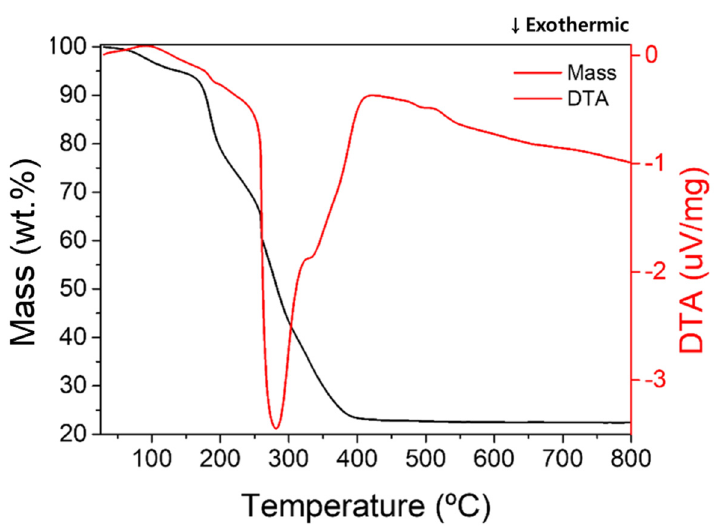
Figure 2. TGA curve of as-spun NZF nanofibers. An initial mass decrease of about 6% occurred in the temperature range of 60 °C to 140 °C, and it was likely due to the volatilization of adsorbed moisture and residual sol- vent. The DTA peaks are 100 °C and 135 °C, respectively, and these reactions are endo- thermic near the boiling points of water and DMF. Endothermic DTA peaks are observed at 100 °C, 135 °C and it is near the boiling point of water and DMF. The mass loss of 16%, starting at around 180 °C, lasts up to 200 °C. The mass-loss rate decreased from 200 °C to 250 °C and then increased. This result explained how the endothermic reaction of glass transition suppressed the exothermic of PVP decomposition. After that, a strong exother- mic reaction and mass loss were observed near 260 °C, which was likely rapid PVP de- composition by ignition and combustion. Then there was a continuous exothermic reac- tion and mass loss by the decomposition of residual carbon black and crystallization of metal ion.